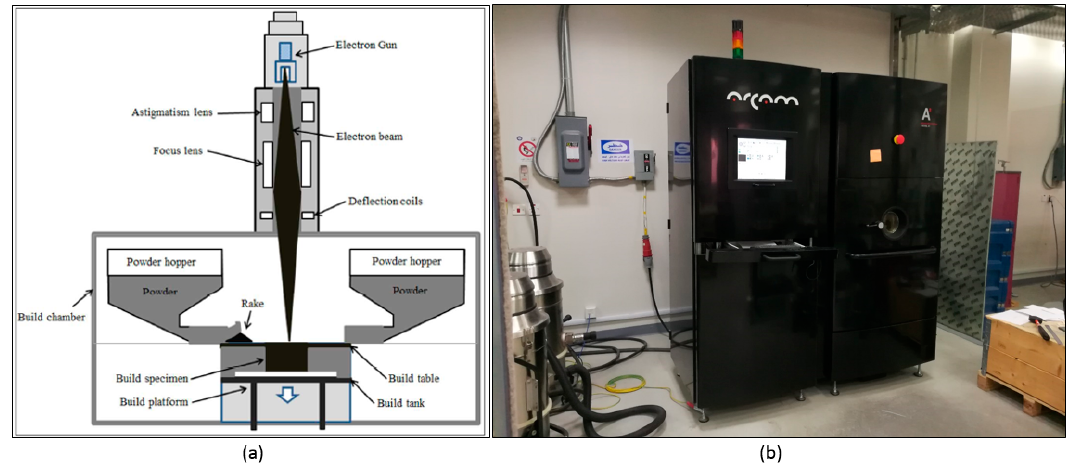
Figure 5. ( a ) Schematic of electron beam melting (EBM); ( b ) ARCAM machine used in this study.